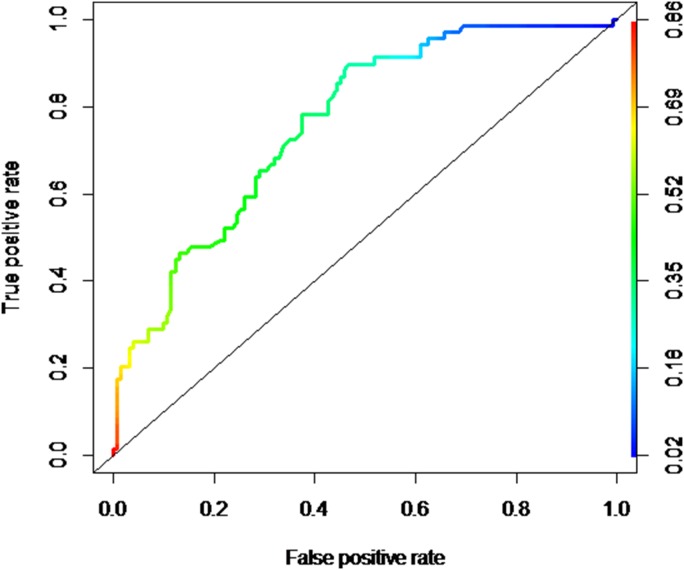
Analysis of the predictive capacity of the logistic regression model related with the high nursing workload factors.São Paulo, Brazil (2010–2011).